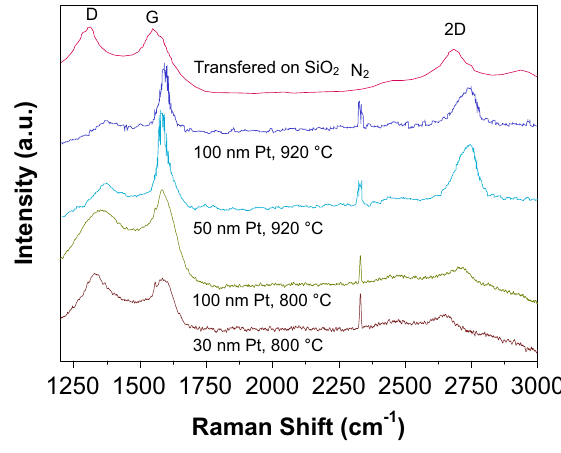
Fig. 2 Raman spectra of graphene grown at 800 °C on 30 nm Pt (red) and 100 nm Pt (green) thin-films and grown at 920 °C on 50 nm Pt (cyan) and 100 nm (purple) thin-films. The Raman spec- trum (magenta) of graphene grown on 50 nm Pt (growth tempera- ture 800 °C) and transferred an oxidized Si wafer is shown for com-